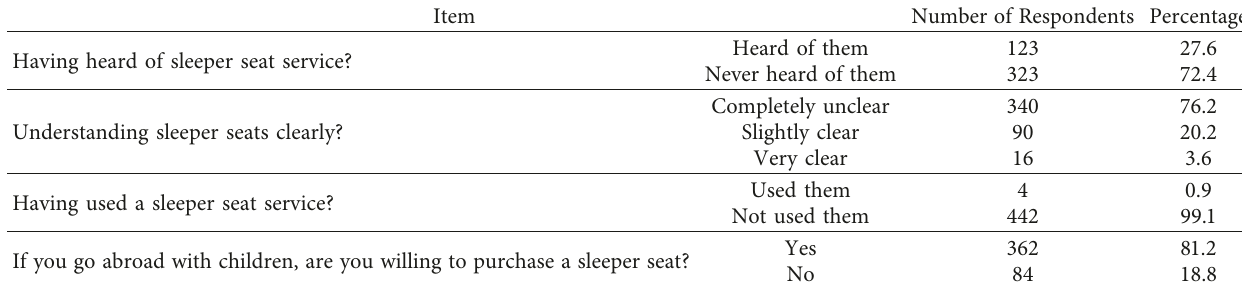
Table 4: Respondents’ awareness of the sleeper seat service (1).